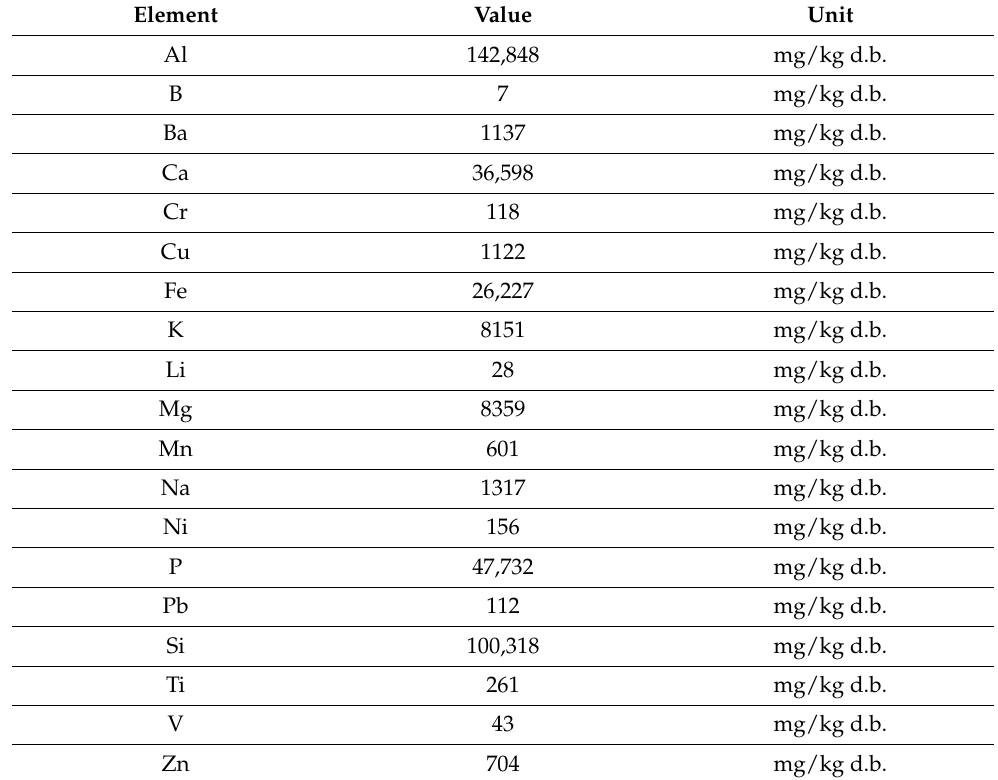
Table 9. Results of the char (from SPYRO pilot plant) proximate, ultimate, and thermal analysis. Parameter Value Unit Moisture 1.2 % w.b. Ash 550 79.0 % d.b. Ash 710 77.7 % d.b. Volatiles 12.5 % d.b. Fixed C 9.9 % d.b. C 14.4